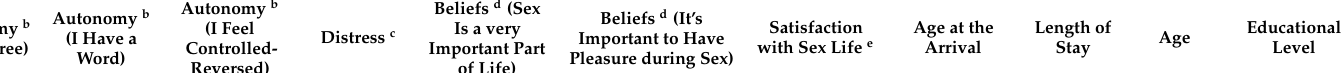
Beliefs d (Sex Beliefs d (It’s Satisfaction Age at the Length of Is a very Important to Have with Sex Life e Arrival Stay Important Part Pleasure during Sex) of Life)